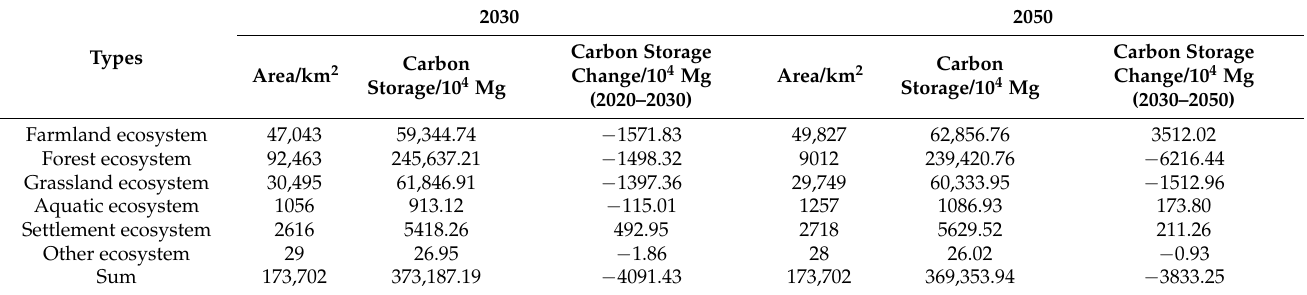
Table 6. Quantitative structure of the carbon storage of the terrestrial ecosystem in 2030 and